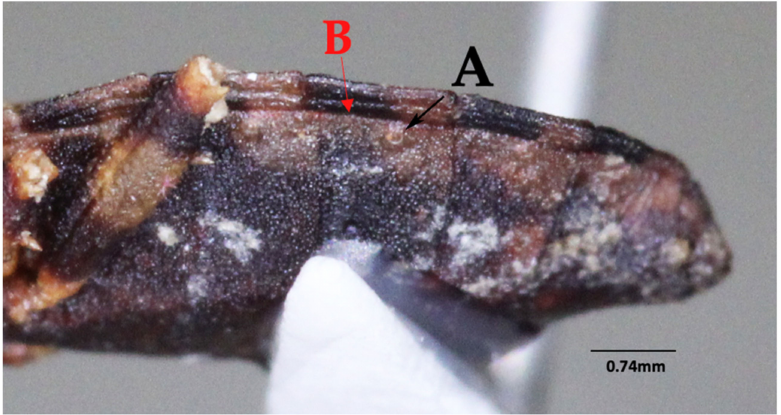
Figure 7. Detail of abdomen of Belminus santosmalletae sp. n., depicting the spiracles ( pointed by arrow A ) being very close but not adjacent to the connexival suture ( pointed by arrow B